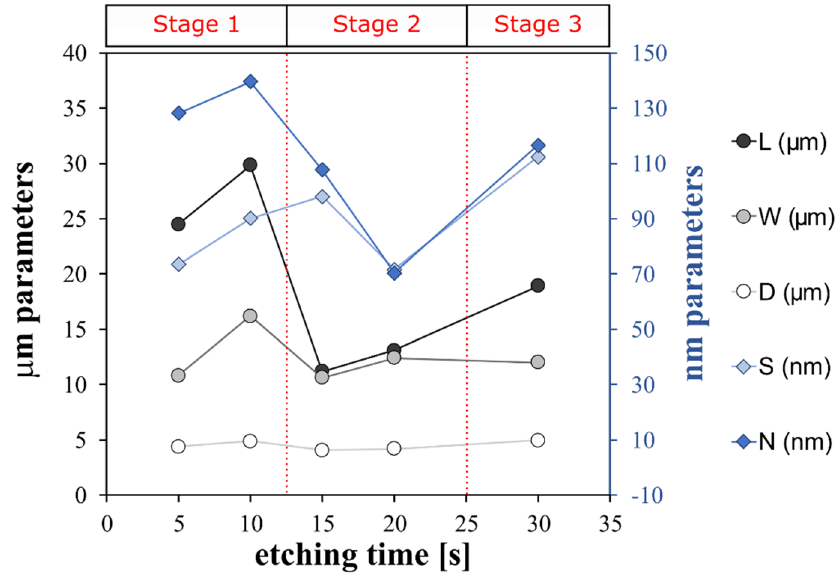
Figure 4. Structure features of superhydrophobic aluminum surfaces etched for different times.